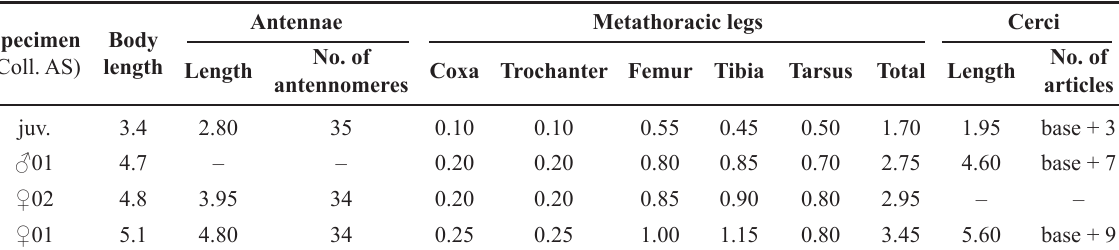
Table 5. Plusiocampa ( Plusiocampa ) hoelzeli (Neuherz, 1984) from Renejevo brezno. Length of the body, antennae, cerci, metathoracic legs and their segments: trochanter, femur, tibia and tarsus (measurements in mm), in addition to the number of antennomeres and cercal